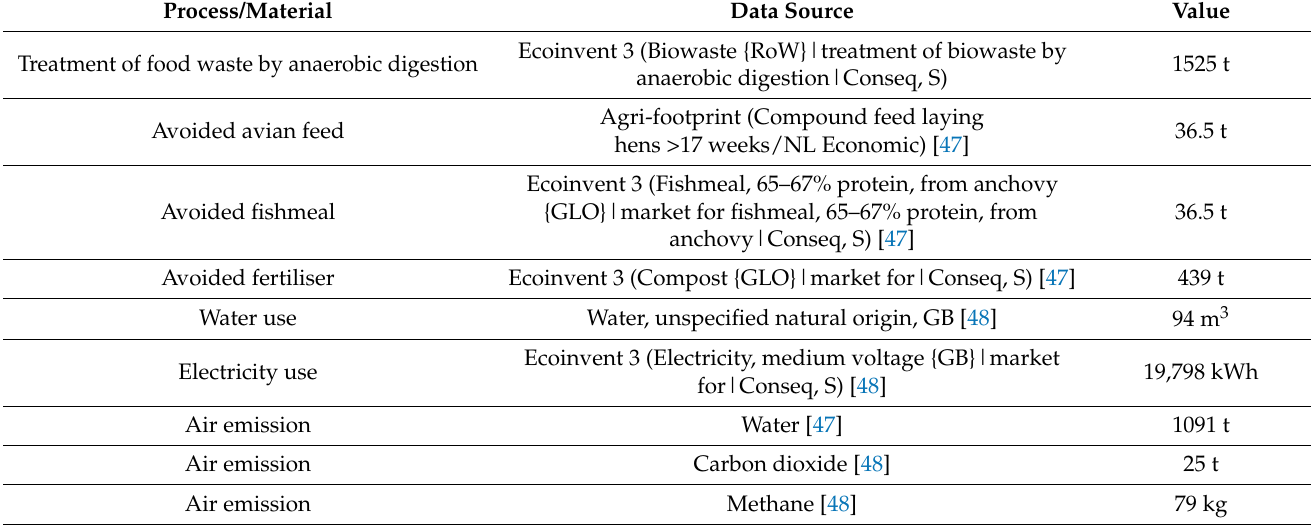
Table 2. Life cycle inventory and data